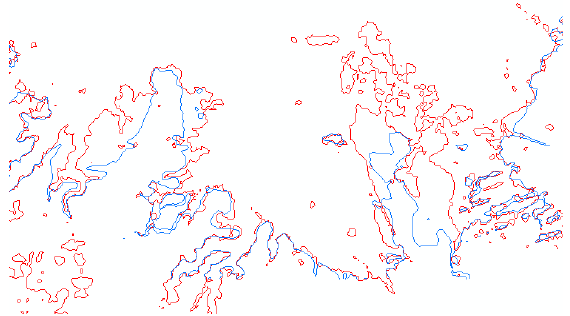
Figure 11. Contour line directly generated from Semi- Automatic DTM (red line) compared to contour line from Manual Stereoplotting DTM (blue line) We can see that the main line showing the close position to each other. The raw generation contour line, then to be edited by selecting and simplification to eliminate unnecessary line based on contour characteristic (Figure 12). Contour line interval 12.5m derived from each DTM can be seen in Figure 10.